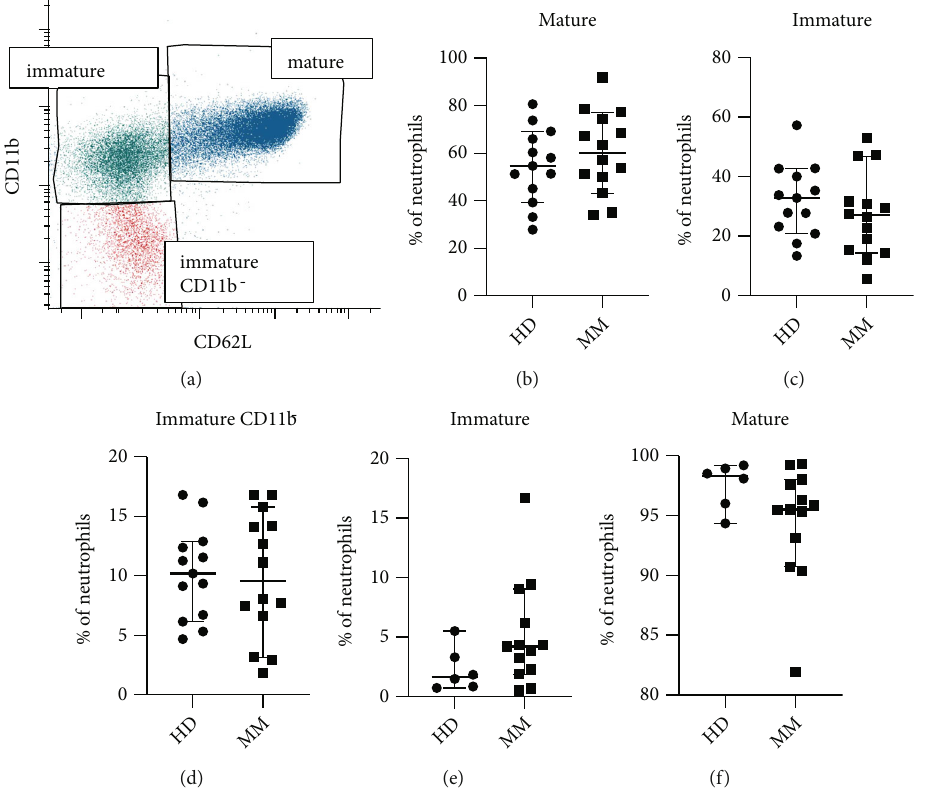
Figure 5: Percentage of mature, immature, and immature CD11b - neutrophils in blood and bone marrow. (a) Gating strategy for the division of bone marrow neutrophils into mature, immature, and immature CD11b - cells. The percentage of (b) mature, (c) immature, and (d) immature CD11b - cells in the bone marrow of healthy donors (HDs) and MM patients. (e) The percentage of immature and (f) mature neutrophils in the blood of healthy donors and multiple myeloma patients. Statistical signi fi cance was tested with Mann – Whitney, but none was